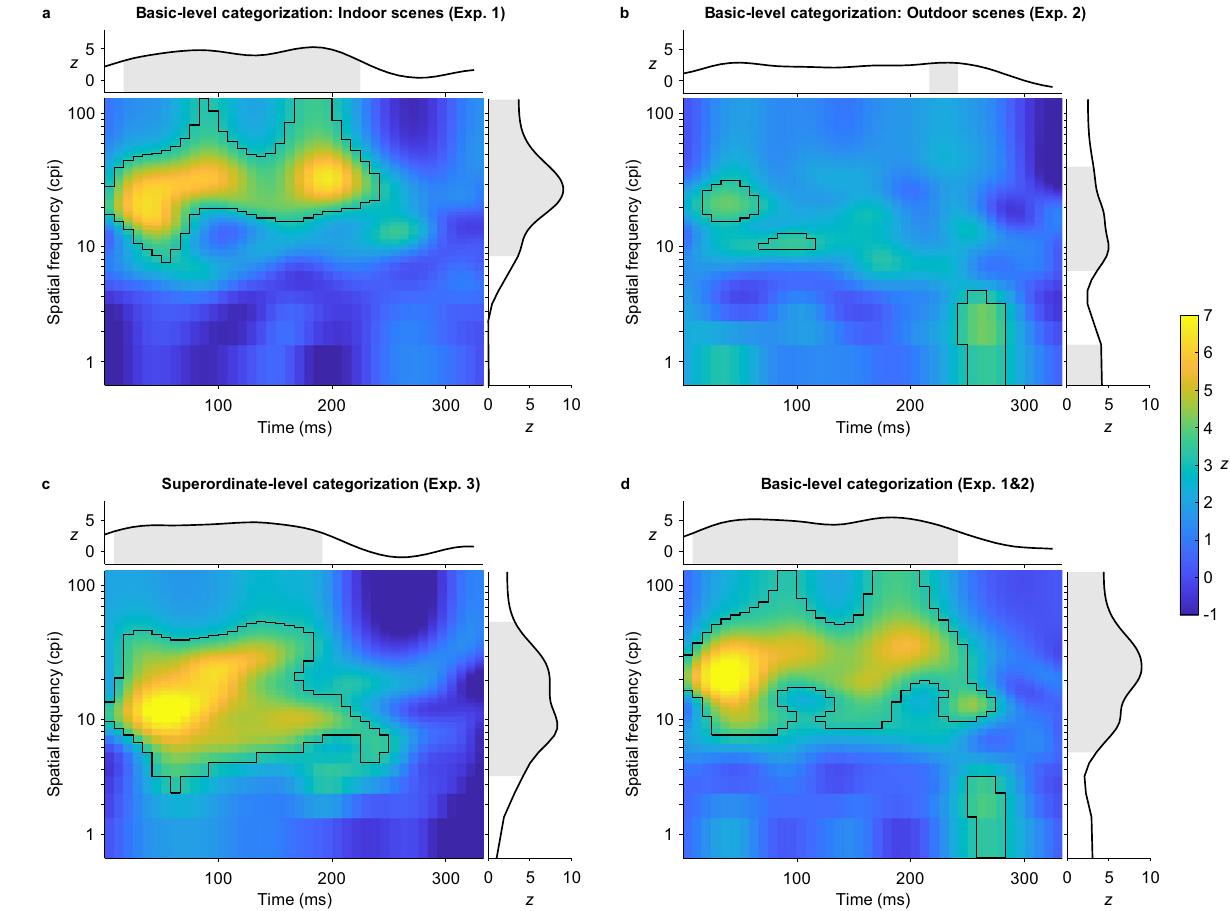
Figure 5. Group classification images obtained from the SF-Bubbles analysis of accuracy data. Basic-level categorization of ( a ) indoor scenes in Experiment 1 and ( b ) outdoor scenes in Experiment 2. ( c ) Superordinate- level categorization of indoor vs. outdoor scenes in Experiment 3. ( d ) Basic-level categorization of indoor and outdoor scenes (pooled data from Experiments 1 and 2). Each pixel indicates how the presentation of a spatial frequency at a given point in time correlates with accuracy in the categorization task. Pixels enclosed by black lines are significant predictors for correct responses. Line plots at the top and on the right of the classification images show results of the Time- and SF-only analyses. Grey areas indicate significant predictors (see text for details). cpi = cycles per